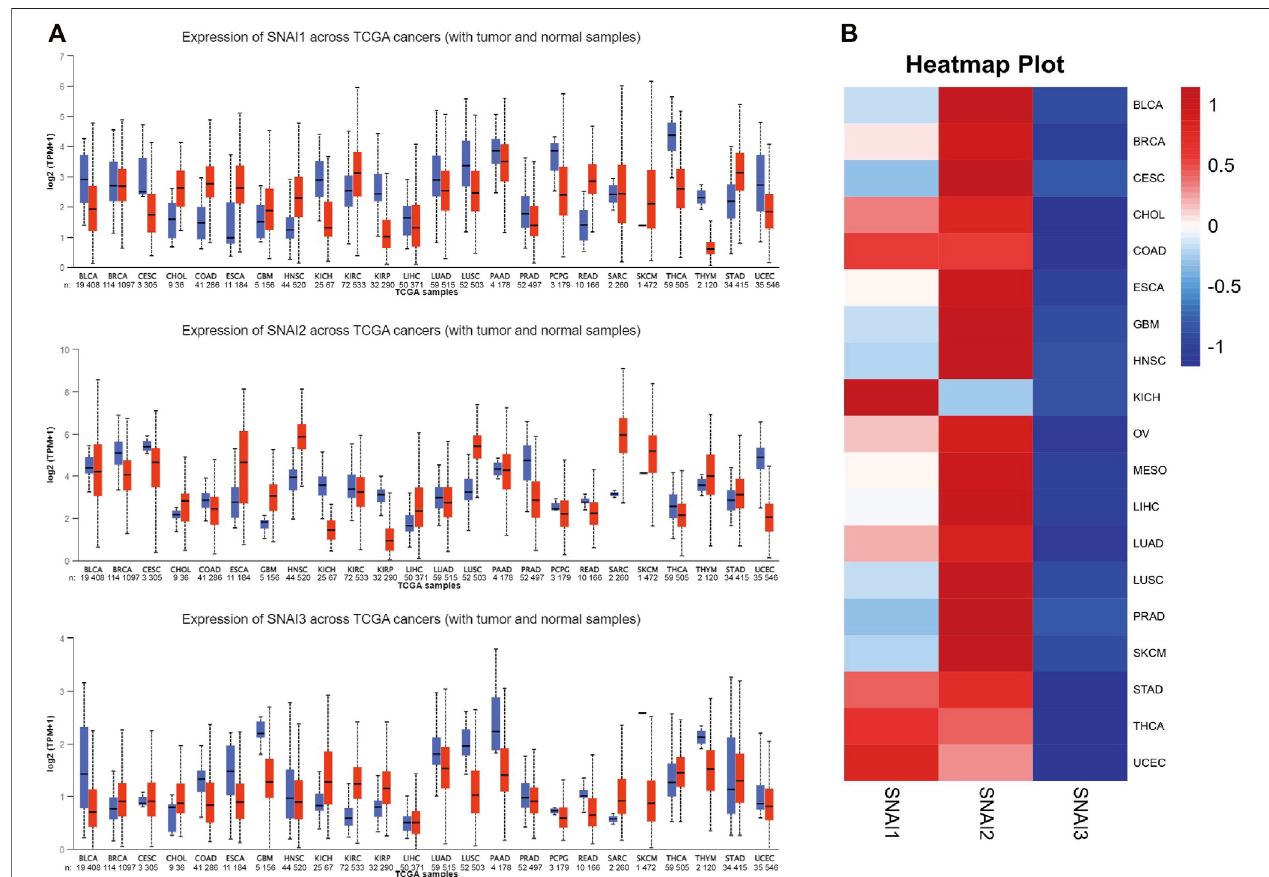
FIGURE1| TranscriptlevelsofSNAIzinc fi ngergenesinvarioustypesofcancers (A) Transcriptlevelsof SNAI1 , SNAI2 ,and SNAI3 intumortissuescomparedwith normal tissues for various cancers (B) Comparison of transcript levels of SNAI1 , SNAI2 , and SNAI3 among various cancer types based on The Cancer Genome Atlas